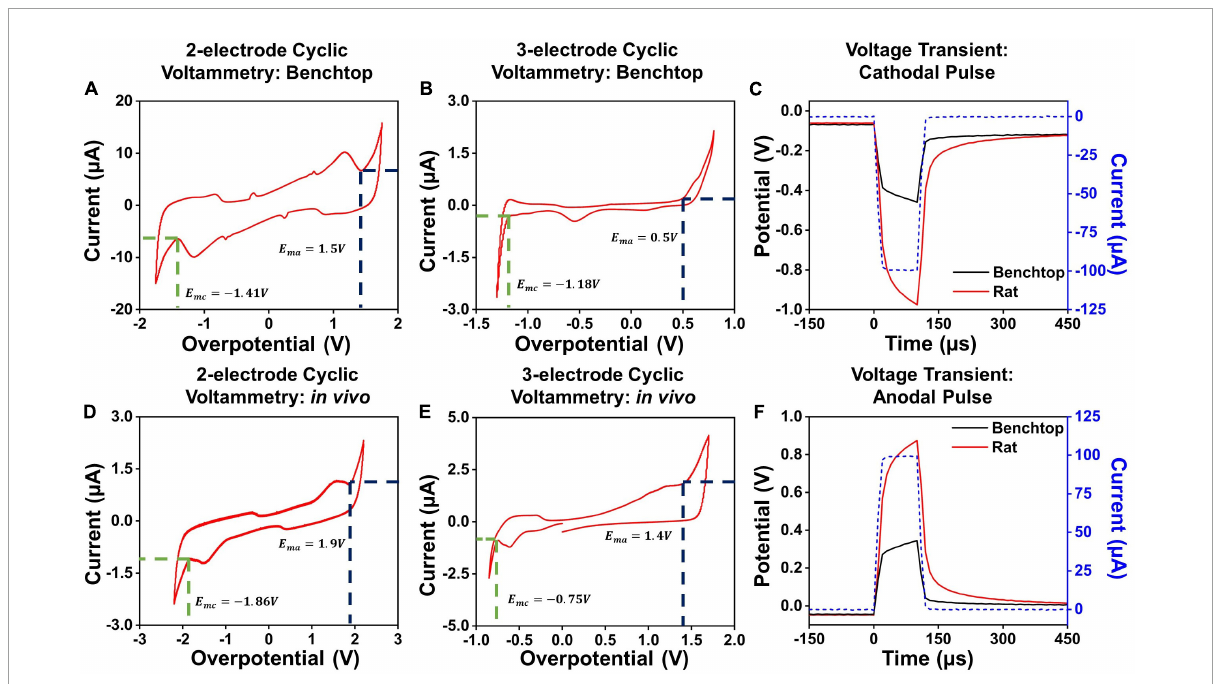
FIGURE3 Cyclic voltammetry measurements in a 2-contact configuration in (A) a benchtop and (D) in vivo setup. Cyclic voltammetry measurements in a 3-contact configuration in (B) a benchtop and (E) in vivo setup. Example voltage transients for a 100 µ A, 100 µ s (C) cathodal and (F) anodal pulse in vivo and in benchtop settings across a PtNR contact with a diameter of 200 µ